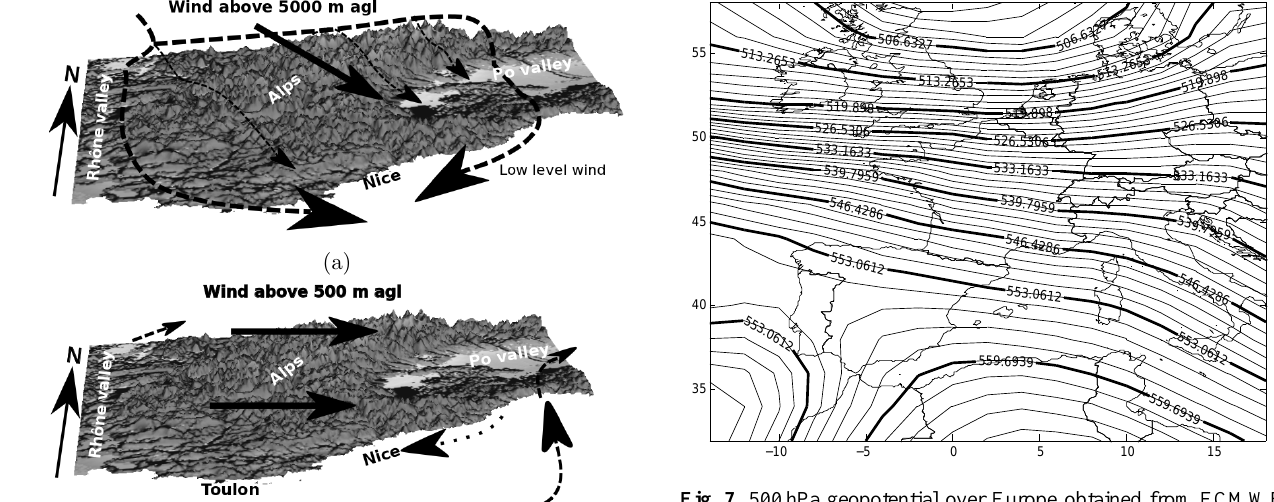
Fig. 7. 500hPa geopotential over Europe obtained from ECMWF analysis at 06:00UTC on the 27 March